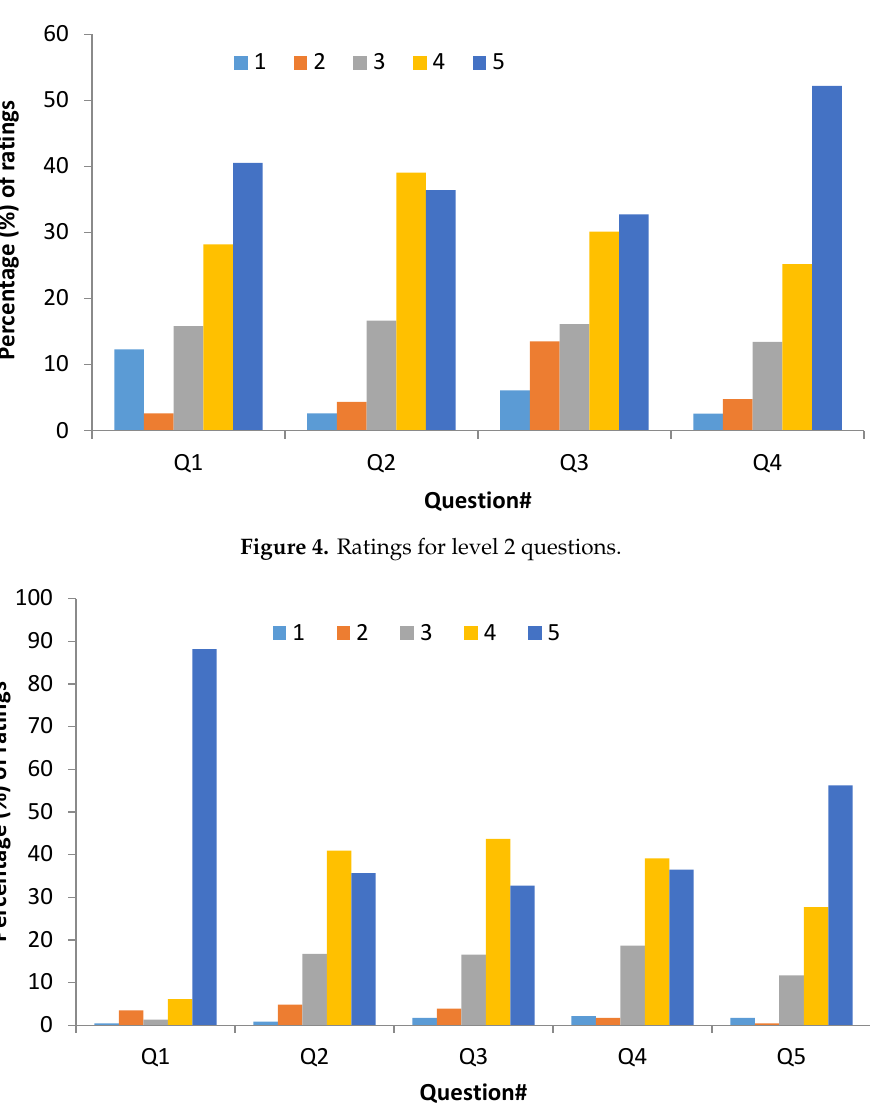
Figure 5. Ratings for level 3 questions.